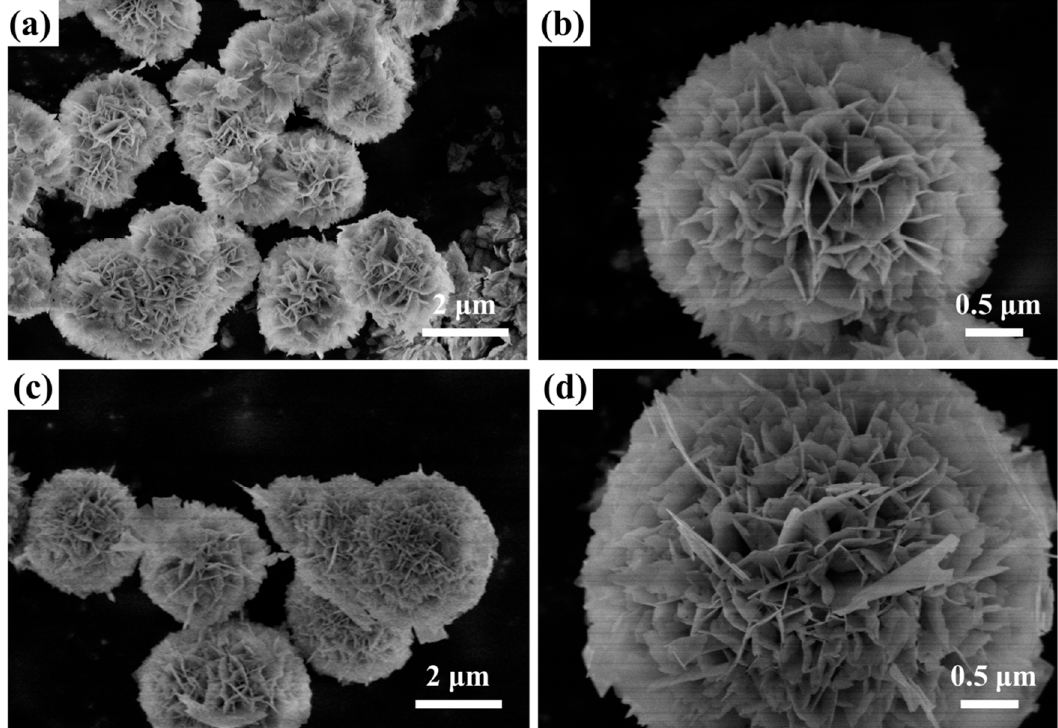
Figure 2. SEM images of ( a,b ) BiOCOOH and ( c,d ) IBOCH-2.